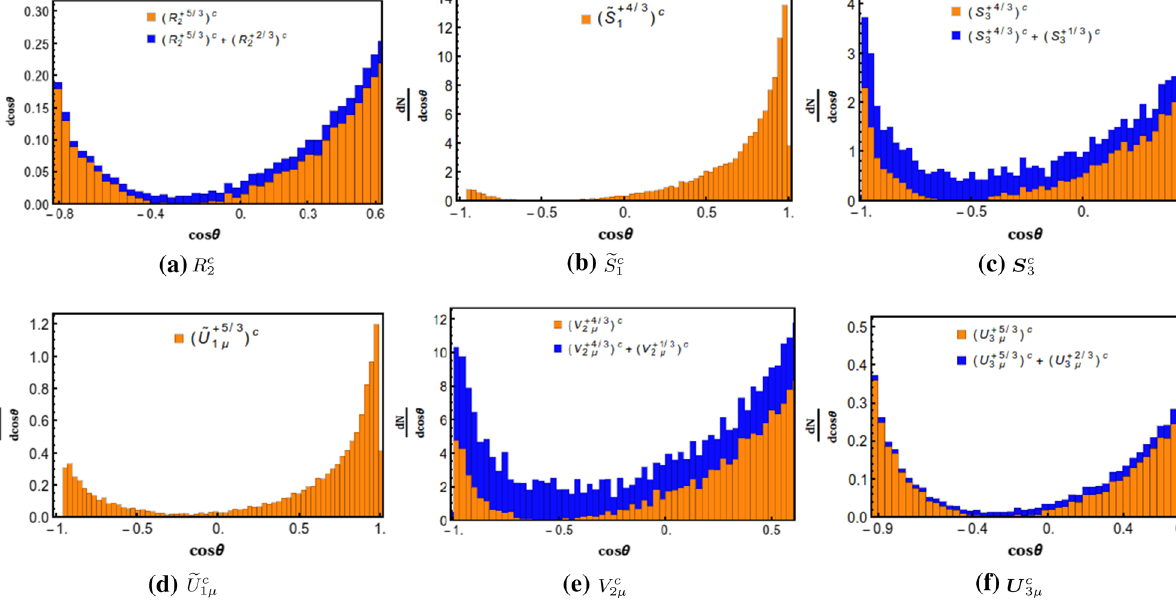
Fig. 18 Distribution of cosine of the angle made by the photon with the electron beam, at a R c , b (cid:8) S c , c S c , d (cid:8) U c , e V c and f U c show the angular distribution for associated leptoquark production with a photon at FCC-I 2 1 3 1 μ 2 μ 3 μ